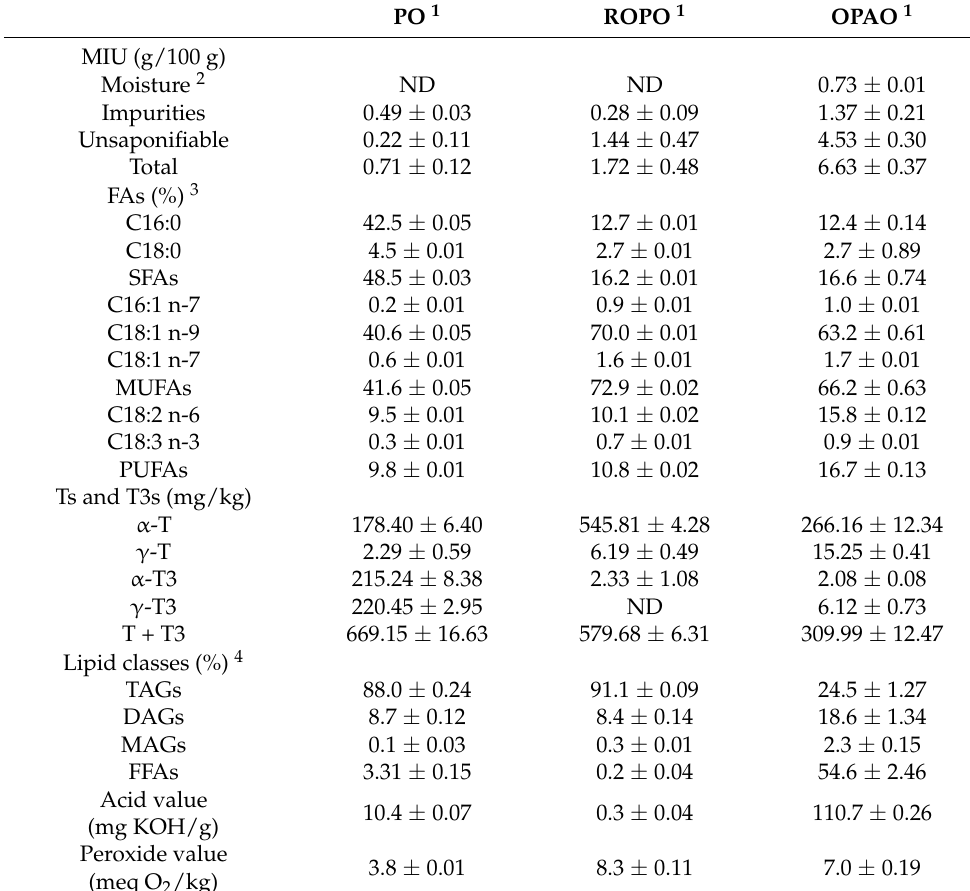
Table 1. Characterization of the experimental fat